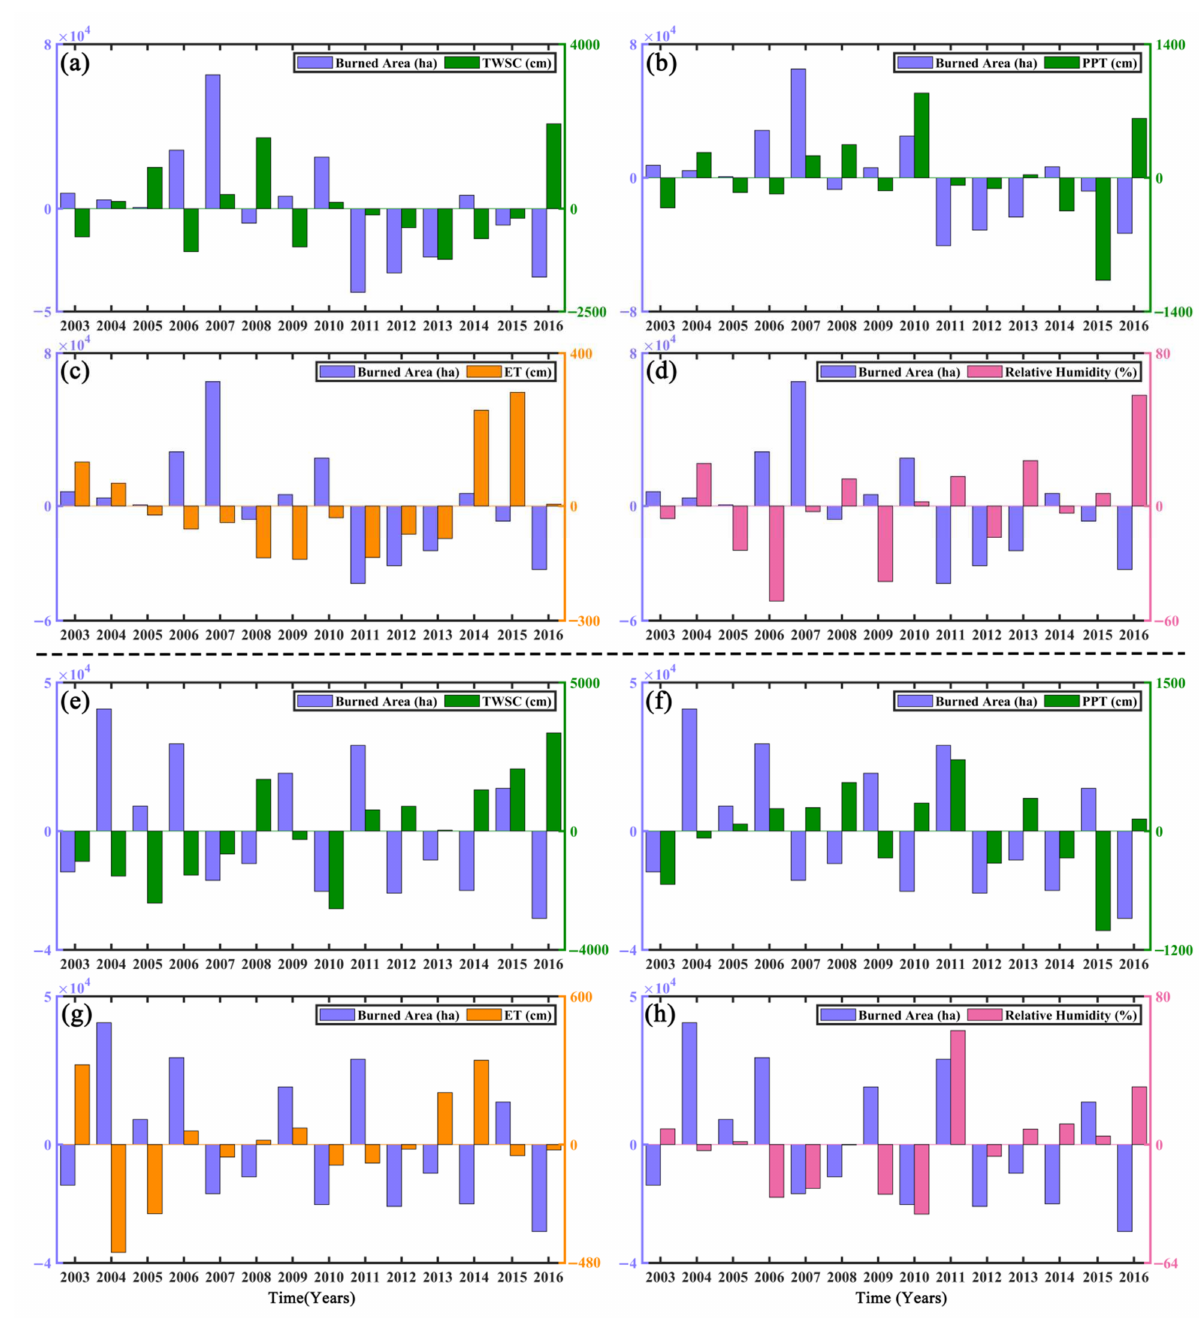
Figure 10. The interannual variation of burned area (ha), TWSC (cm), PPT (cm), ET (cm) and relative humidity (%) from 2003 to 2016 in the region NW ( a – d ) and S ( e – h ). The interannual variation was obtained by subtracting the average of all years from the data for each year. The four figures above the blank dotted line are for region NW, and the four ones below are for region